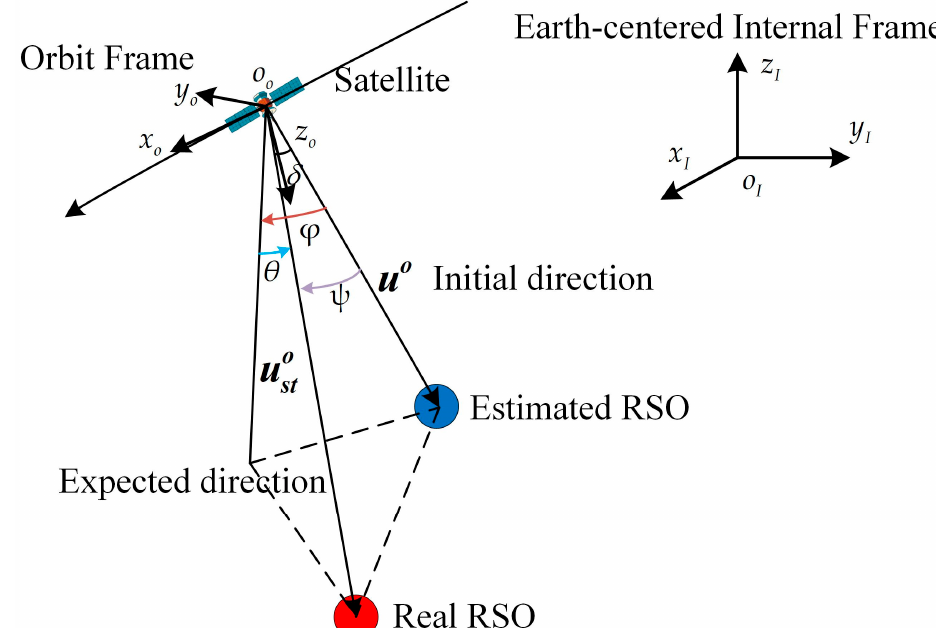
Figure 3. The process of satellite attitude maneuver in staring–tracking imaging mode. Figure 3 shows the satellite maneuvering process from the initial direction to the expected direction. Before we calculate the expected satellite attitude, then two frames should be defined first. The Earth-centered (ECI) internal frame: the original point is the Earth center, the z axis points to the north pole, the x axis points to the spring equinox in the equator plane, and the y axis obeys the right-hand rule in the equator plane. The orbit frame: the original point is the satellite center, the z axis points to the Earth center in the orbit plane, the x axis is the same as the satellite moving direction in the orbit plane, and the y-axis obeys the right-hand rule. In the orbit frame, the satellite changes the yaw ψ , roll ϕ , pitch θ angel around the z, x, and y axes, which meets the requirements of staring–tracking. Additionally, the expected three‑axis attitude can be expressed as the expected quaternion Q c